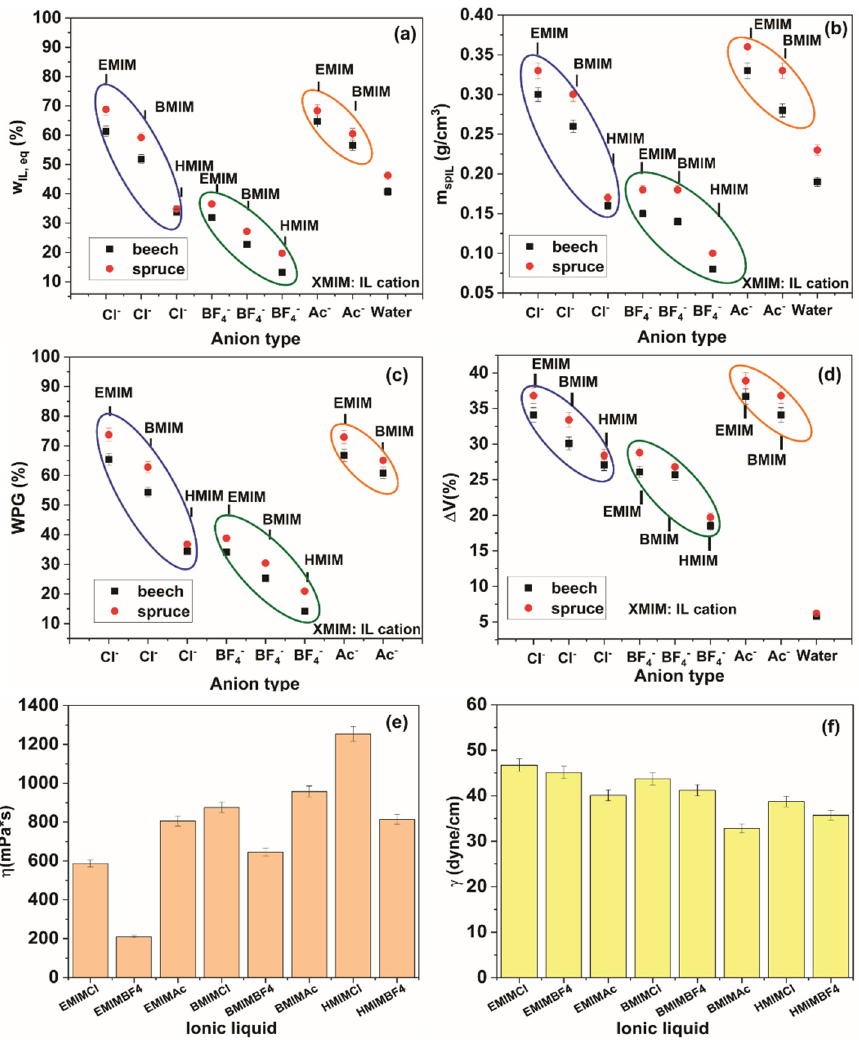
Figure 1. ( a ) Relative amount of ILs absorbed at equilibrium in spruce and beech wood; ( b ) specific mass of absorbed ILs at equilibrium for spruce and beech wood; ( c ); wood percent gain of spruce and beech wood swollen in ILs; ( d ) relative volumetric modifications of spruce and beech wood swollen in ILs; ( e ) kinematic viscosities of the ILs at 25 °C; and ( f ) surface tension of the ILs at 25 °C.